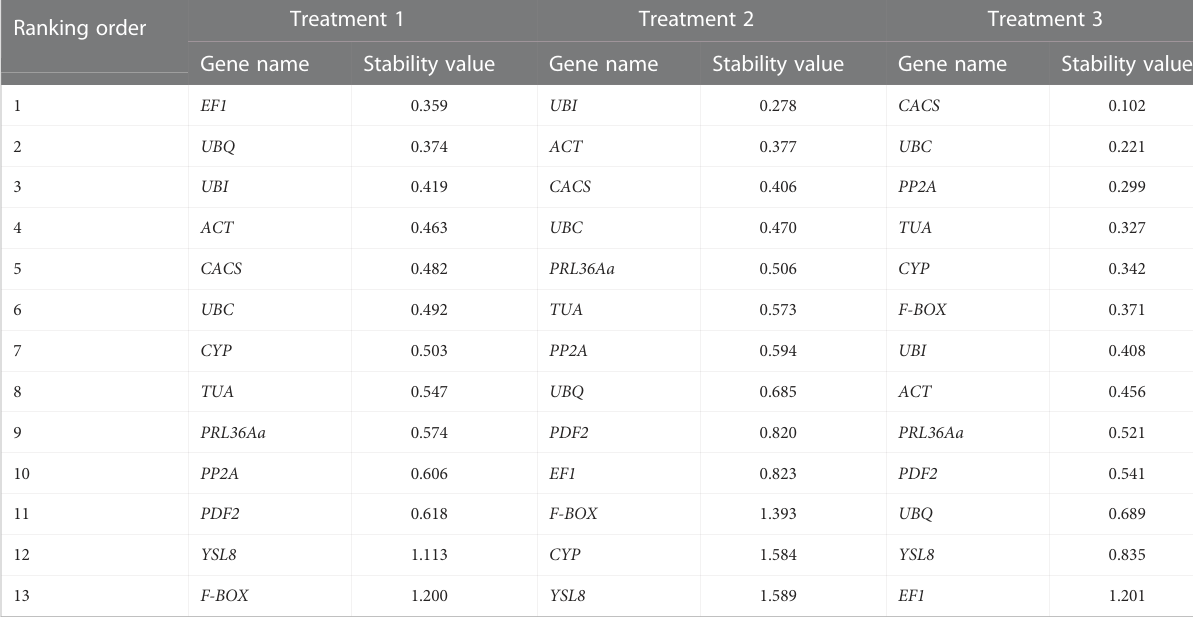
TABLE 2 Ranking and expression stability values of candidate genes by